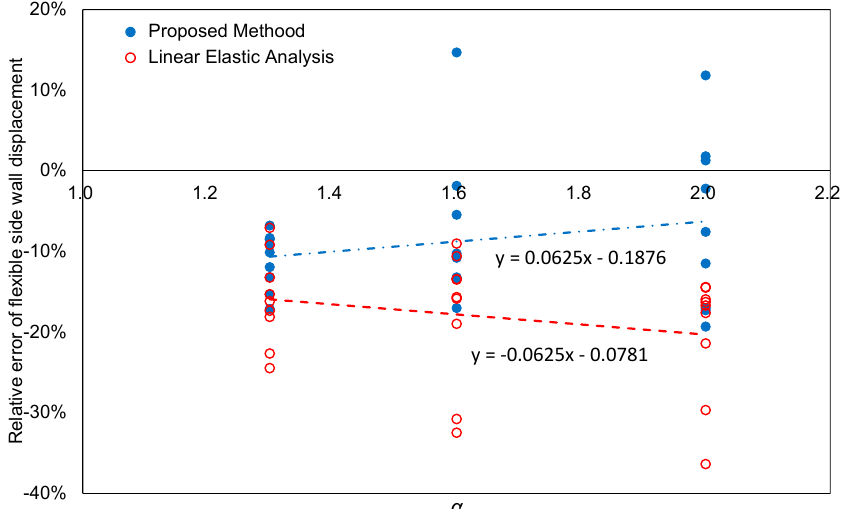
Figure 19. Comparison between the relative errors of the flexible side wall maximum displacement computed by the two methods with respect to α .